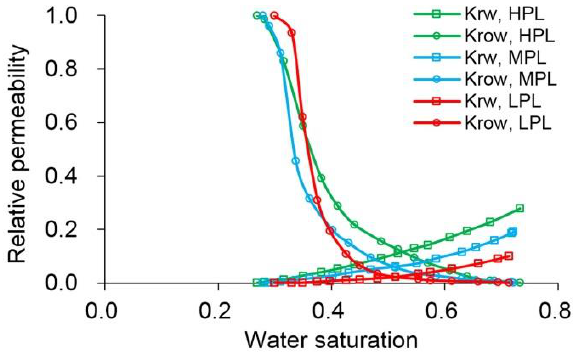
Figure 9. The relative permeabilities used in Case 1.